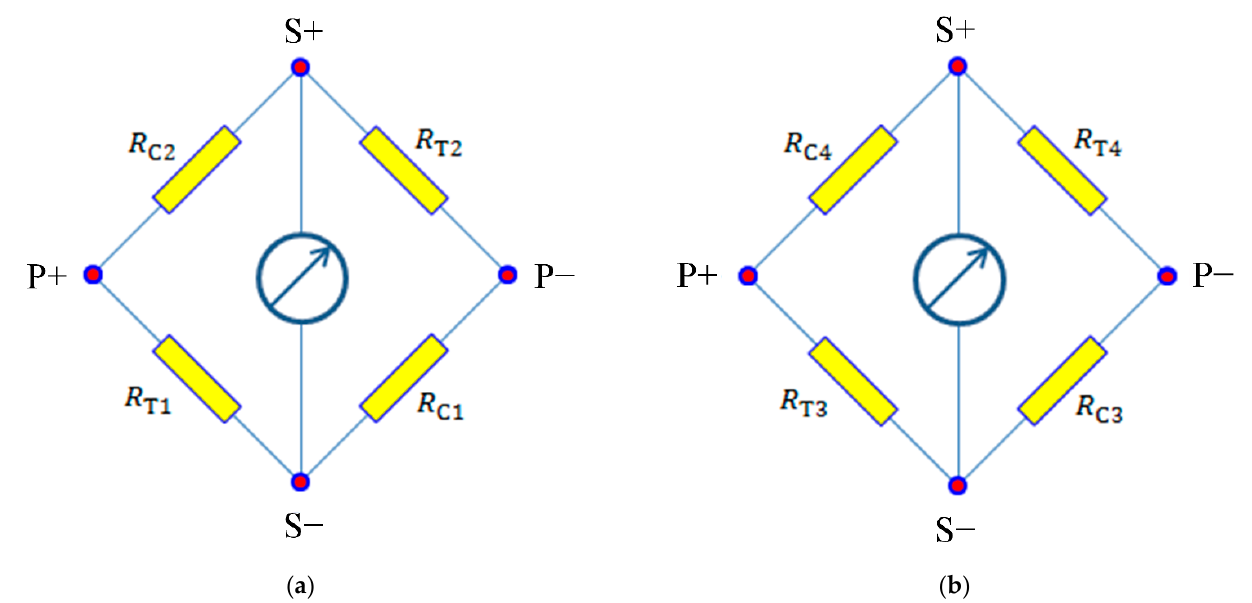
Figure 4. Schematic diagram of measuring bridge: ( a ) In X direction; ( b ) In Y direction.